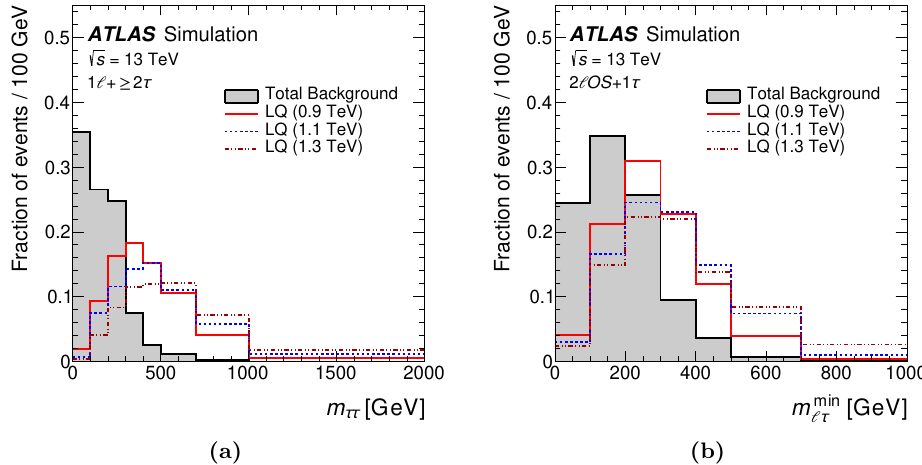
Figure 2. Comparison of the distribution of (a) the invariant mass of the two leading τ had candidates ( m ), and (b) the minimum invariant mass of a light lepton and a τ ττ the total background (shaded histogram) and the LQ signal for different mass values. The selection used in (a) corresponds to events in the 1 ‘ + ≥ 2 τ category after the requirements of p τ and p τ > 50 GeV, whereas the selection used in (b) corresponds to events in the 2 ‘ OS+1 τ category T , 2 after the requirement of p τ > 150 GeV. The last bin in each distribution contains the T